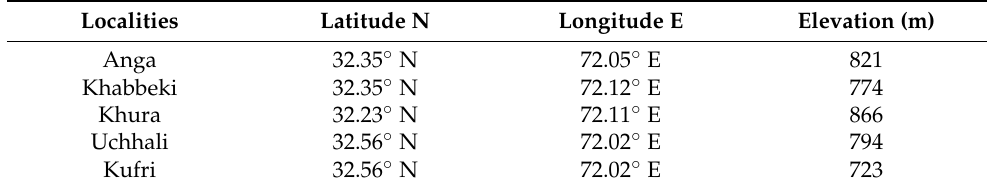
Table 2. Geographical coordinates of the study sites of Soone Valley (Khushab) and the surrounding salt range of Pakistan.